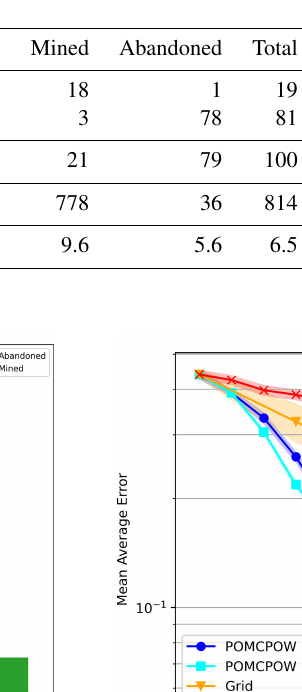
Table 4. Single-body, variable-location POMCPOW results with action constraints.